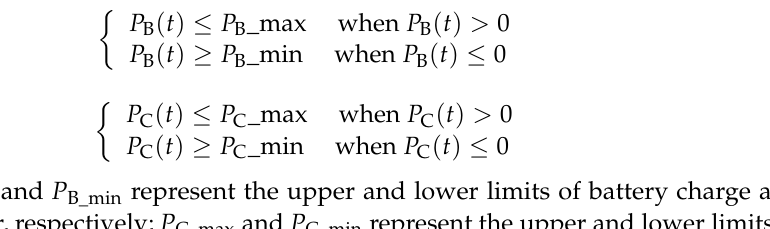
Figure 4. Structure diagram of the limiting control layer.